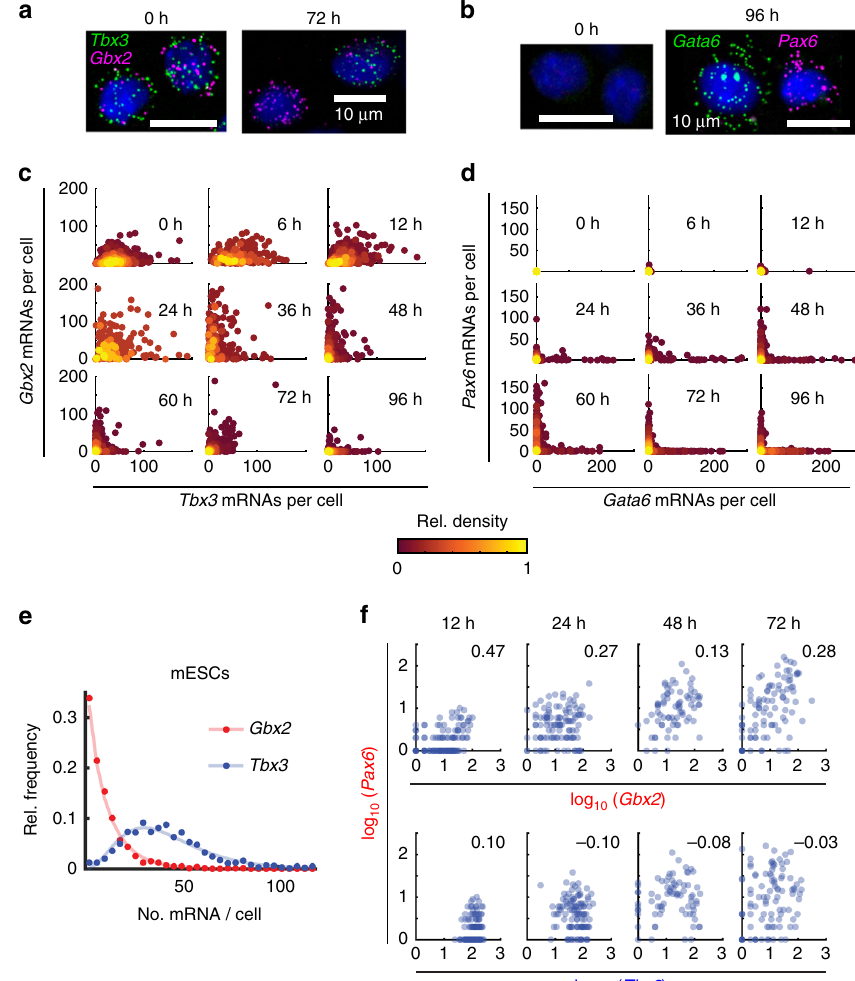
Fig. 7 smFISH con fi rmed distinct expression patterns of exemplary transcription factors. a Fluorescence images of smFISH for Gbx2 and Tbx3 in mESCs (0 h) and after 72 h RA exposure. Each diffraction limited dot corresponds to a single mRNA molecule. Hoechst staining of nuclei is shown in blue. b Fluorescence images of smFISH for Pax6 and Gata6 in mESCs (0 h) and after 96 h RA exposure. Each diffraction limited dot corresponds to a single mRNA molecule. Hoechst staining of nuclei is shown in blue. c Scatter plots of the number of Gbx2 and Tbx3 mRNAs per cell measured by smFISH. Each data point is a single cell. Color indicates the local density of data points. The number of shown cells measured at a certain time point ranges between 224 and 983. d Scatter plots of the number of Pax6 and Gata6 mRNAs per cell measured by smFISH. Each data point is a single cell. Color indicates the local density of data points. The number of shown cells measured at a certain time point ranges between 293 and 570. e Distribution of the Tbx3 and Gbx2 transcripts in individual mESCs as measured by smFISH. Both data sets are fi t by a Gamma distribution ( Tbx3 , R 2 = 0.94, solid blue line; Gbx2 , R 2 = 0.99, solid red line). f Scatter plots of the number of mRNAs per cell for Gbx2 and Tbx3 vs Pax6 measured by smFISH. Each data point is a single cell. Cells were exposed to RA for 12 h, 24 h, 48 h and 72 h, respectively, as indicated above each column of panels. The number in each panel is the Pearson